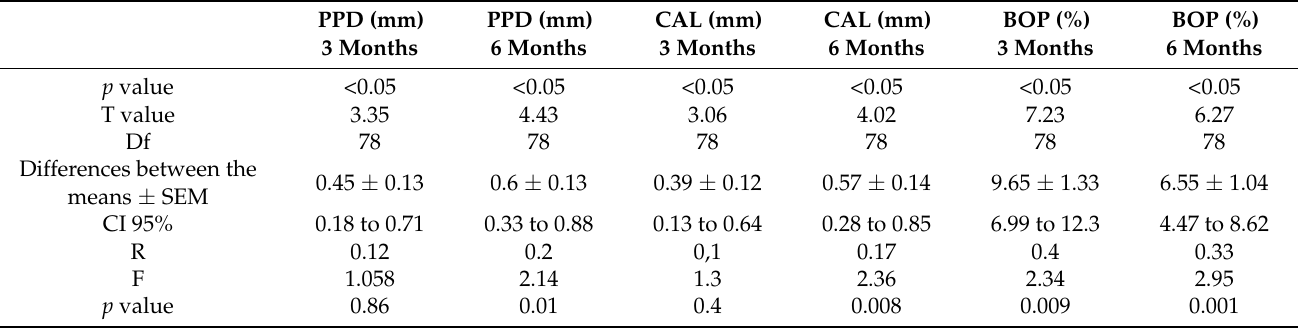
Table 5. Unpaired T test results at 3 and 6